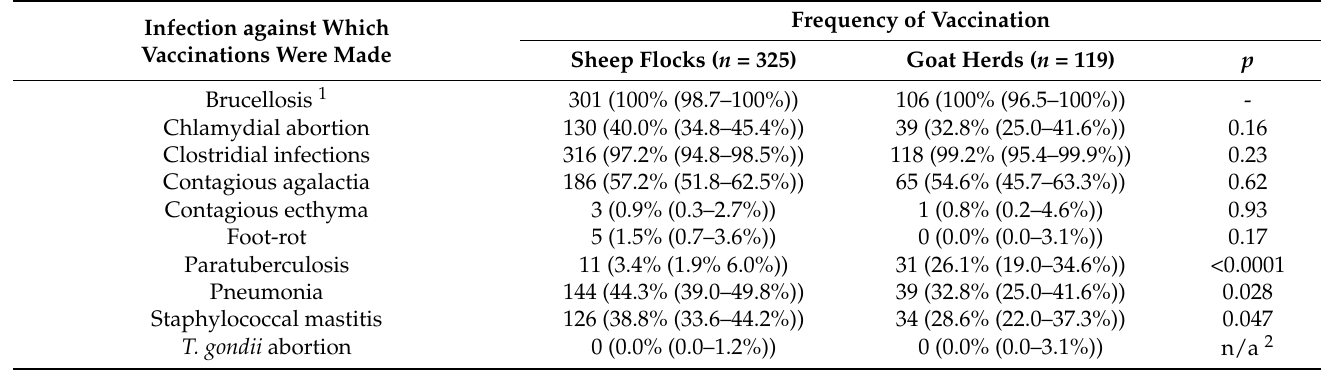
Table 1. Descriptive findings (number of farms (proportion (95% confidence interval))) regarding administration of vaccines in small ruminant farms in